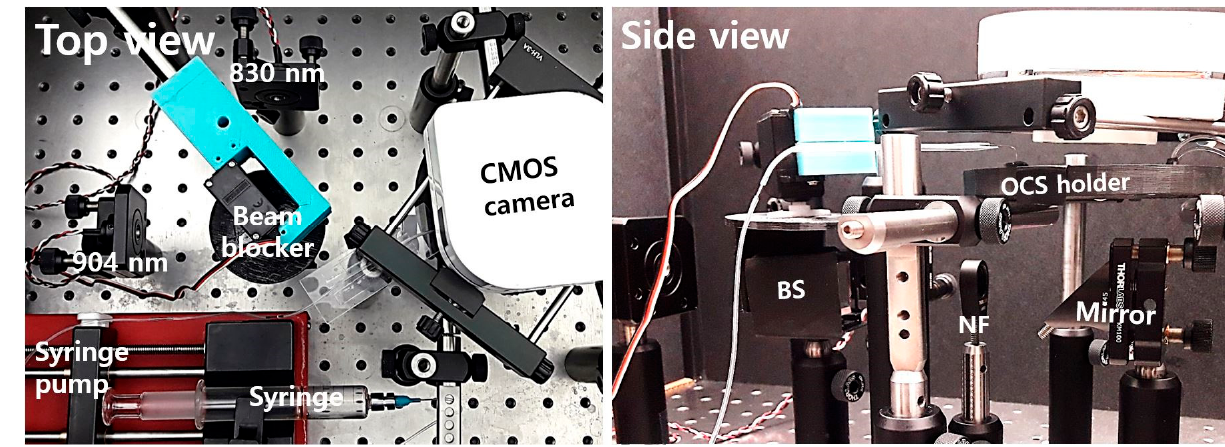
Figure 4. Top and side views of the test setup for the optical cavity-based biosensor (OCB).